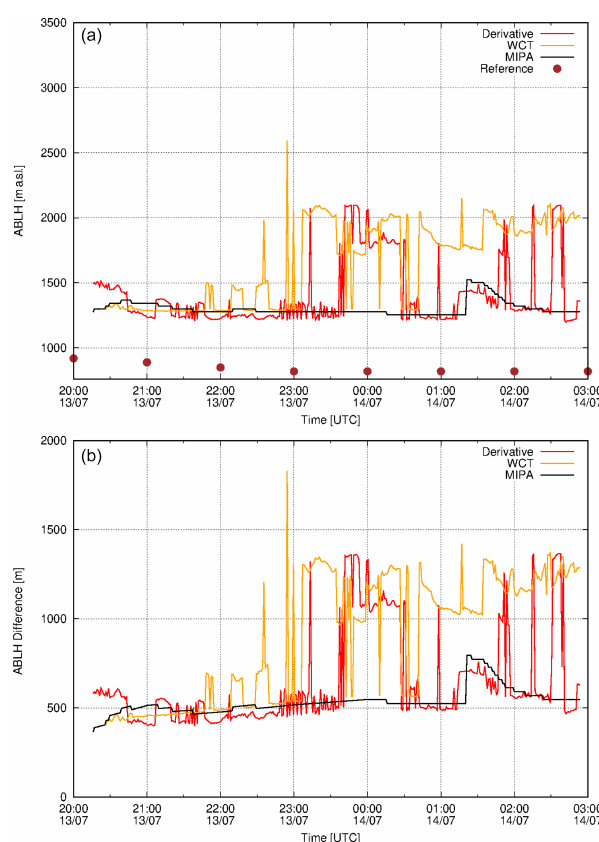
Figure 10. (a) ABLH retrieved from the Potenza lidar measure- ments on 13 July 2015. Black, red and yellow lines show the ABLH retrieved from 1064nm high-resolution total attenuated backscat- ter time series applying MIPA, derivative and WCT algorithms, respectively. Brown circles are the reference ABLHs as retrieved from atmospheric temperature and pressure profiles provided by ECMWF forecasts. (b) Absolute differences between the retrieved ABLHs with respect to the reference. The original time resolution of ECMWF forecasts data is 1h. They have been interpolated at the lidar data time resolution (60s).